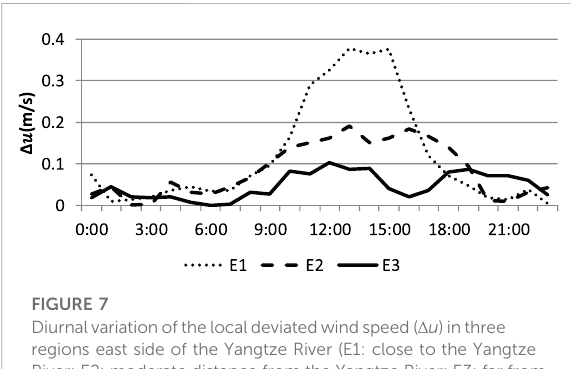
FIGURE 7 Diurnalvariationofthelocaldeviatedwindspeed( Δ u )inthree regions east side of the Yangtze River (E1: close to the Yangtze River; E2: moderate distance from the Yangtze River; E3: far from the Yangtze